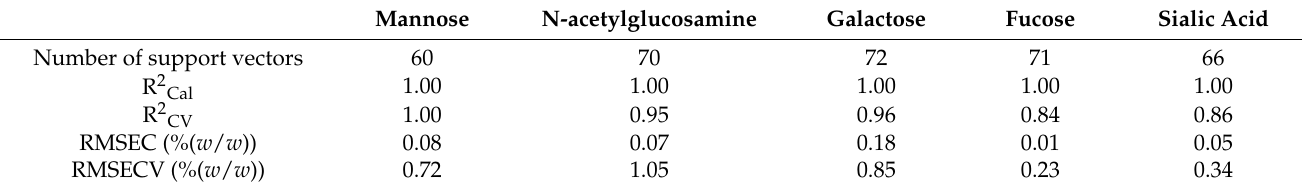
Figure 10. Measured versus predicted amounts of monosaccharides obtained by SVR regression between 800 and 1150 cm − 1 for the analysis of the amount of each glycan at low concentration (3 mg mL − 1 ) of mAbs.